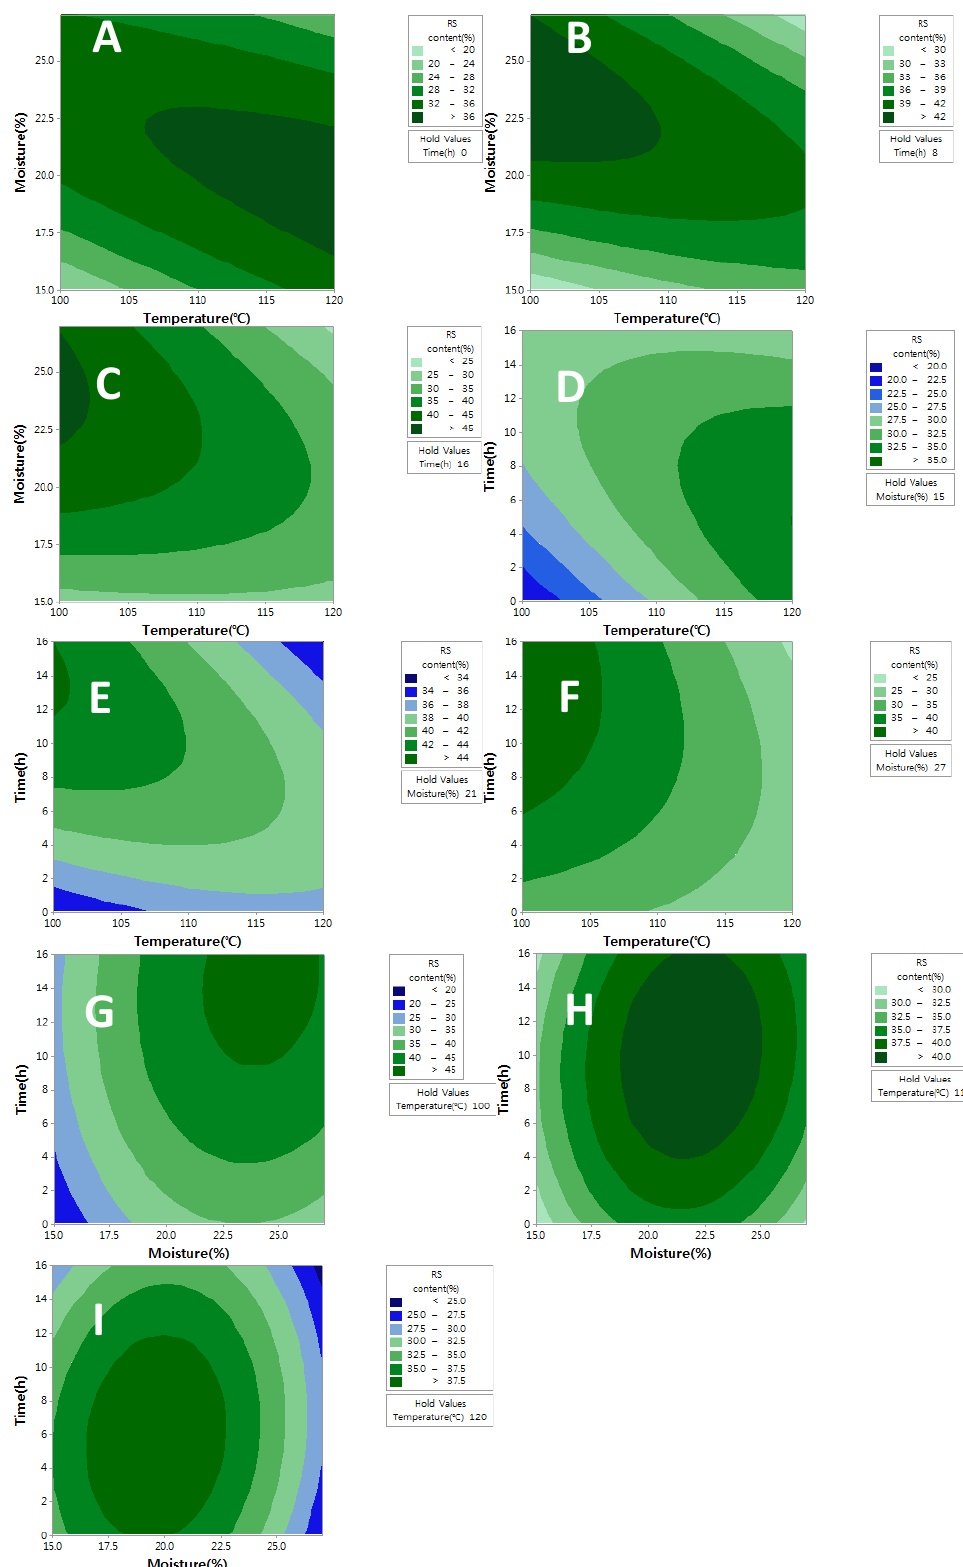
Figure 1. Contour plots for the effects of two variables under a constant one variable. ( A − C ): Treatment time was fixed for 0, 8 and 16 h, respectively. ( D − F ): Moisture level was fixed at 15, 21 and 27%, respectively. ( G − I ): Temperature was fixed at 100, 110 and 120 °C, respectively.